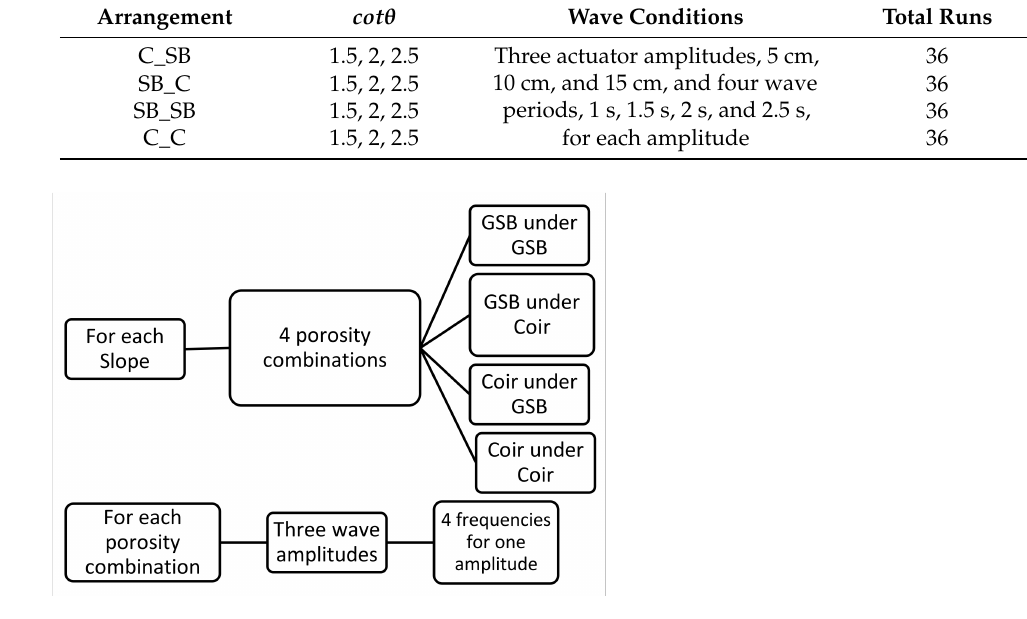
Figure 6. Process flow diagram.